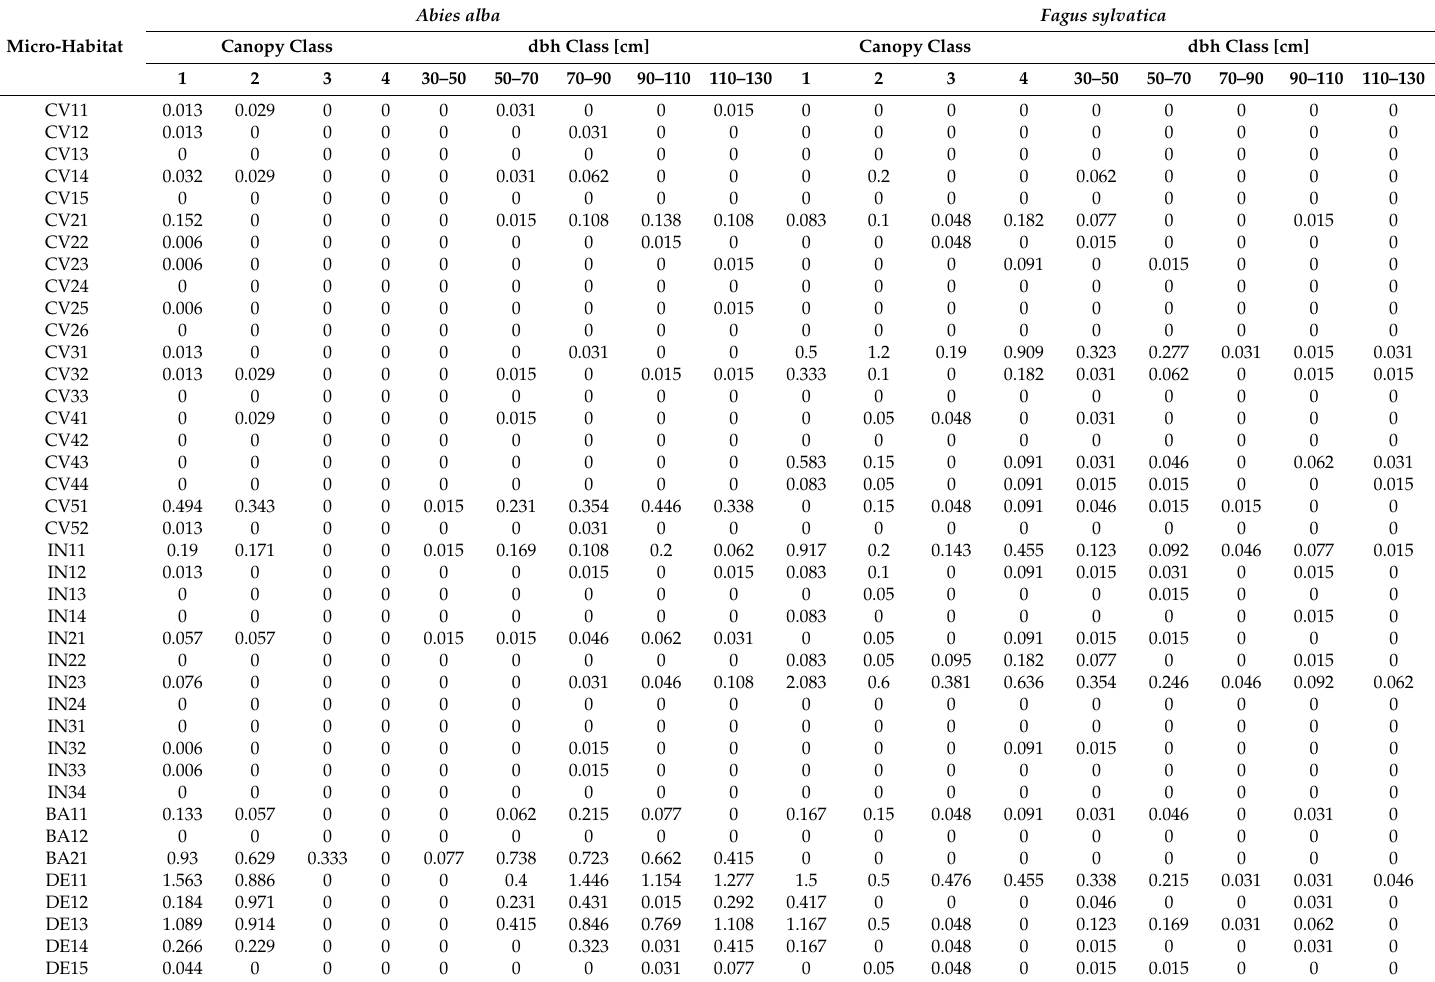
Table A3. Microhabitat frequencies on Abies alba and Fagus sylvatica in regard to canopy and dbh classes. For microhabitat codes, see Table